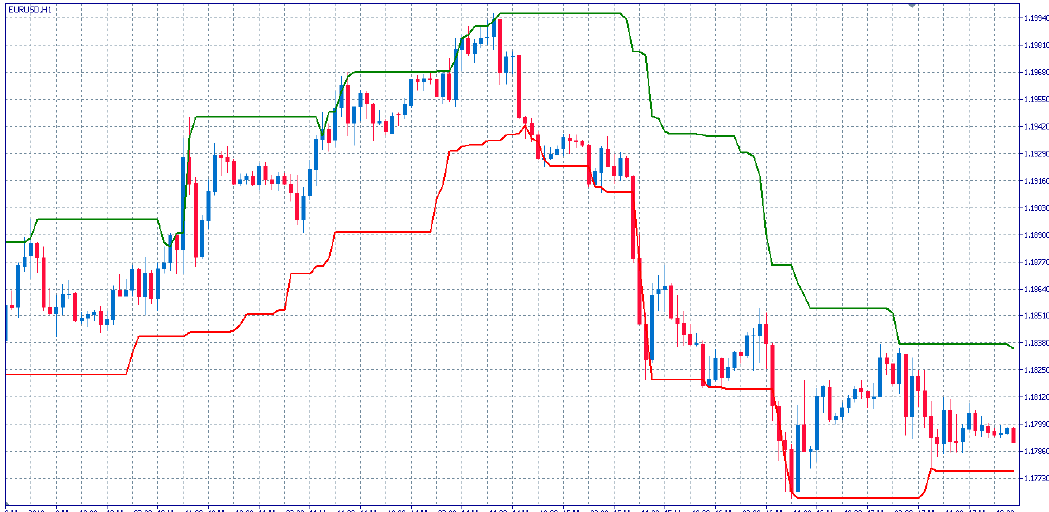
Figure 1. Donchian Channels of period 20 on a EURUSD H1 chart.